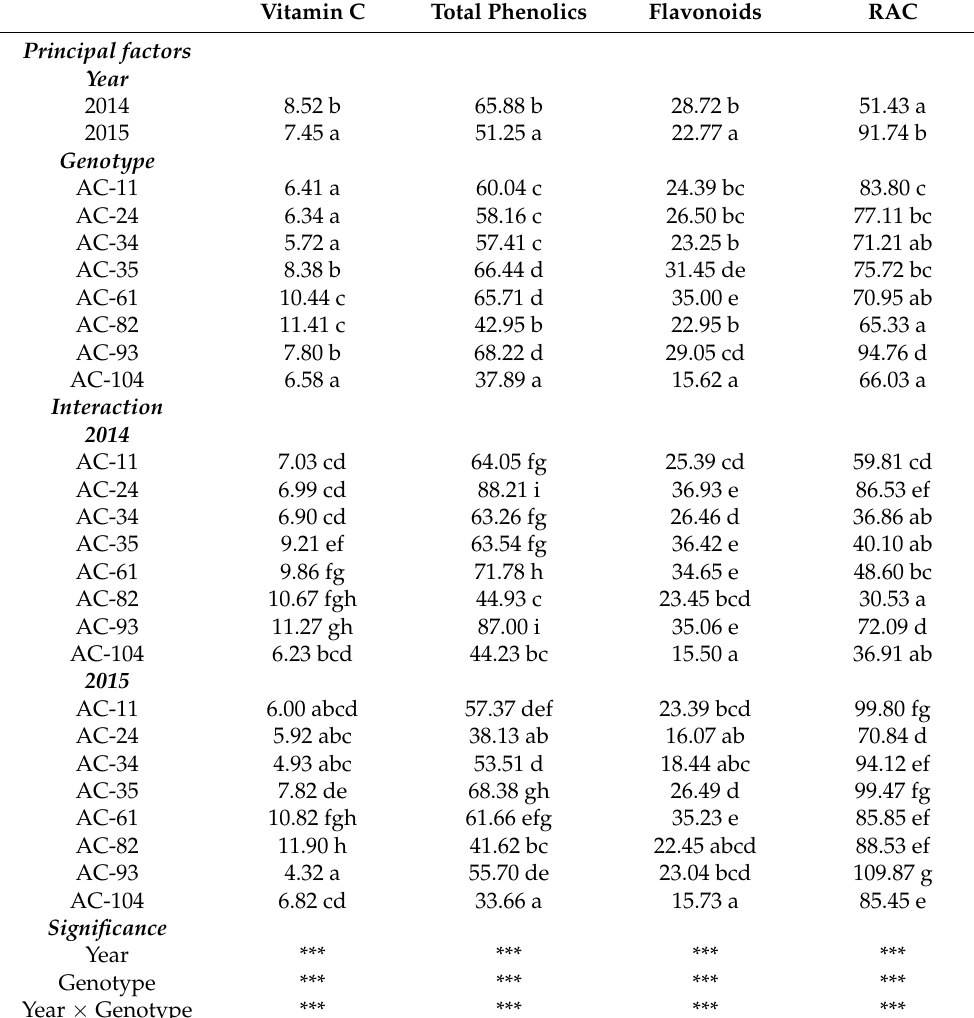
Table 6. Antioxidant compound contents and relative antioxidant capacity in the flesh of eight genotypes selected from the ‘Andross’ × ‘Calante’ population evaluated during the two years of study (2014–2015). For each genotype, means are from N = 2–3 replicates each